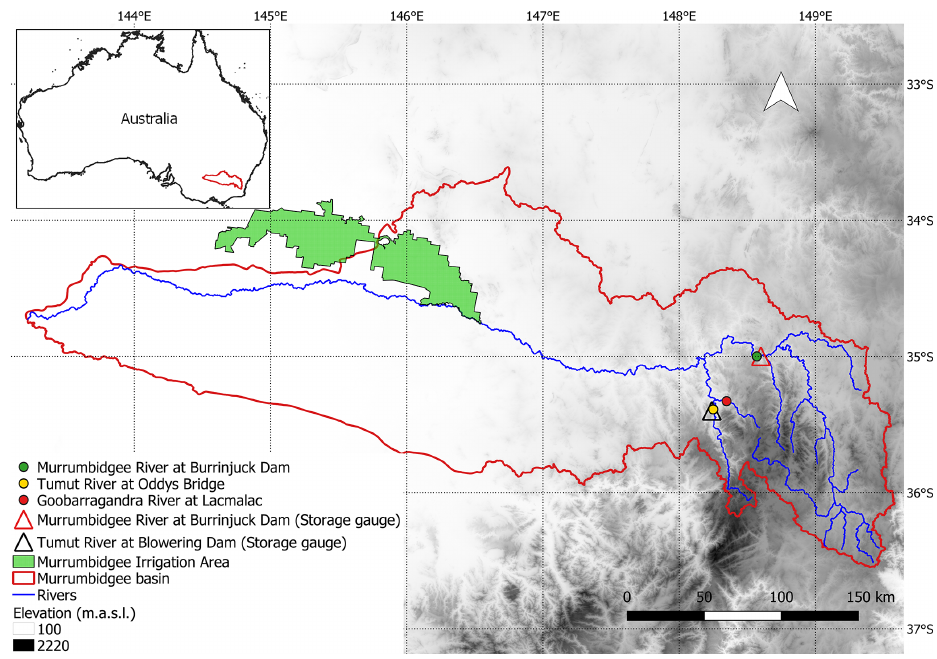
Figure 1. Map of the Murrumbidgee River basin in Australia. Location of the Murrumbidgee irrigation area, discharge stations (Mur- rumbidgee River at Burrinjuck Dam, Tumut River at Oddy’s Bridge, and Goobarragandra River at Lacmalac) and storage gauges in the Burrinjuck and Blowering reservoirs.